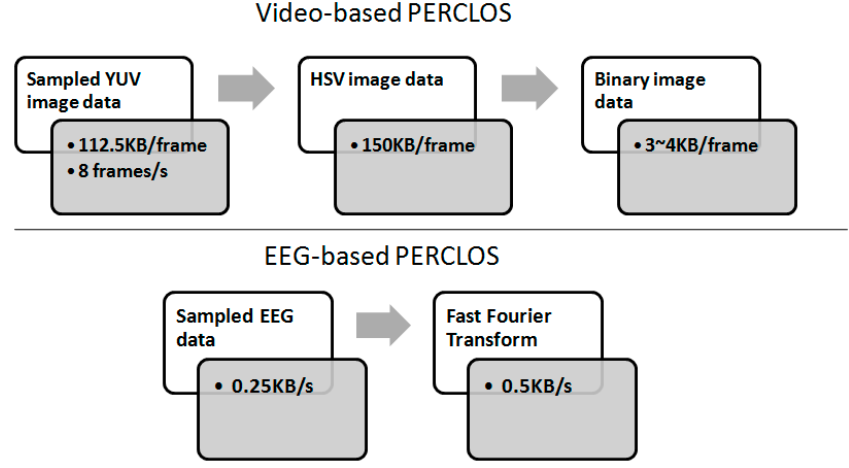
Figure 17. Computational load comparison between video-based ( upper ) and EEG-based PERCLOS ( bottom